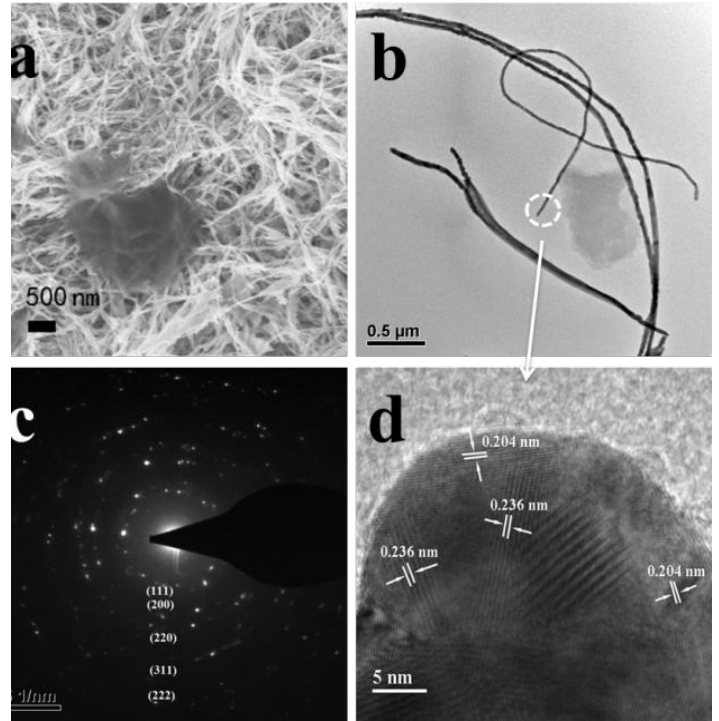
Figure 2. ( a ) Scanning electron microscopy (SEM) image; ( b ) transmission electron microscopy (TEM) image; ( c ) selected-area electron diffraction (SAED) pattern and ( d ) High-resolution TEM (HRTEM) image of Au-Ag/nanowires (NWs).